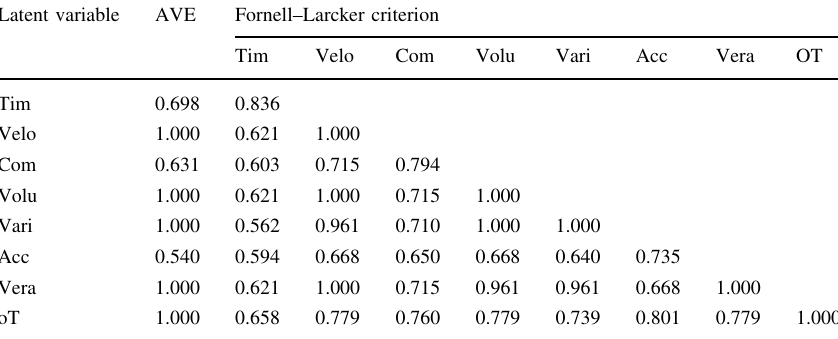
Table 6 Results of the testing measures for the formative measurement models Latent